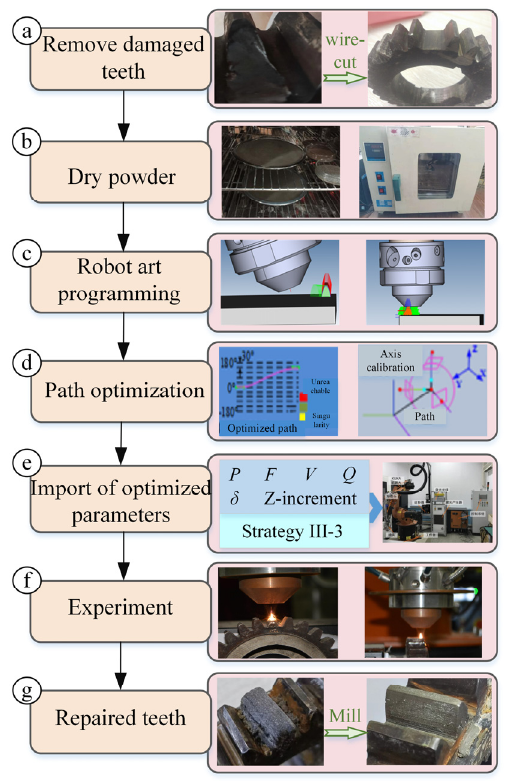
Figure 13. The machining process of gear teeth.